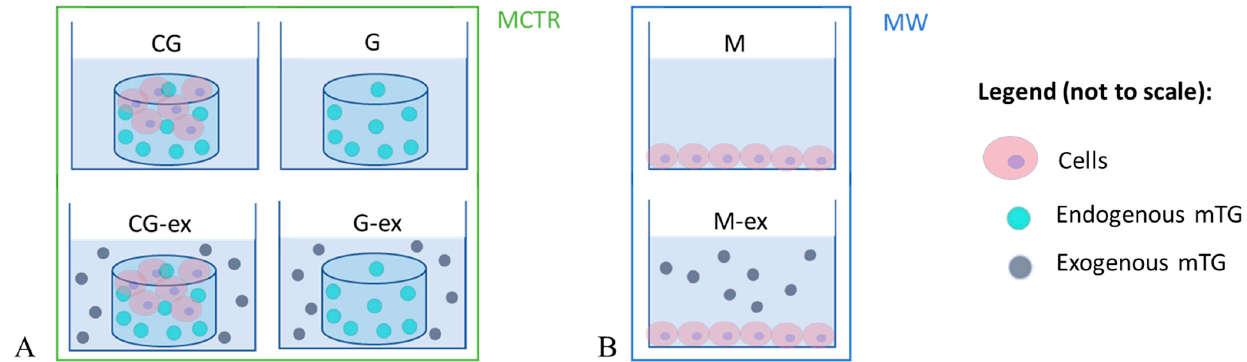
Figure 3. Summary of the experimental setup and acronyms: ( A ) samples tested in the bioreactor, i.e., cell-laden gels (CG), cell-laden gels with exogenous mTG (CG-ex), gels (G) and gels with exogenous mTG (G-ex); ( B ) monolayers in multiwell plates cultured in the absence (M) and in the presence of exogenous mTG (M-ex).